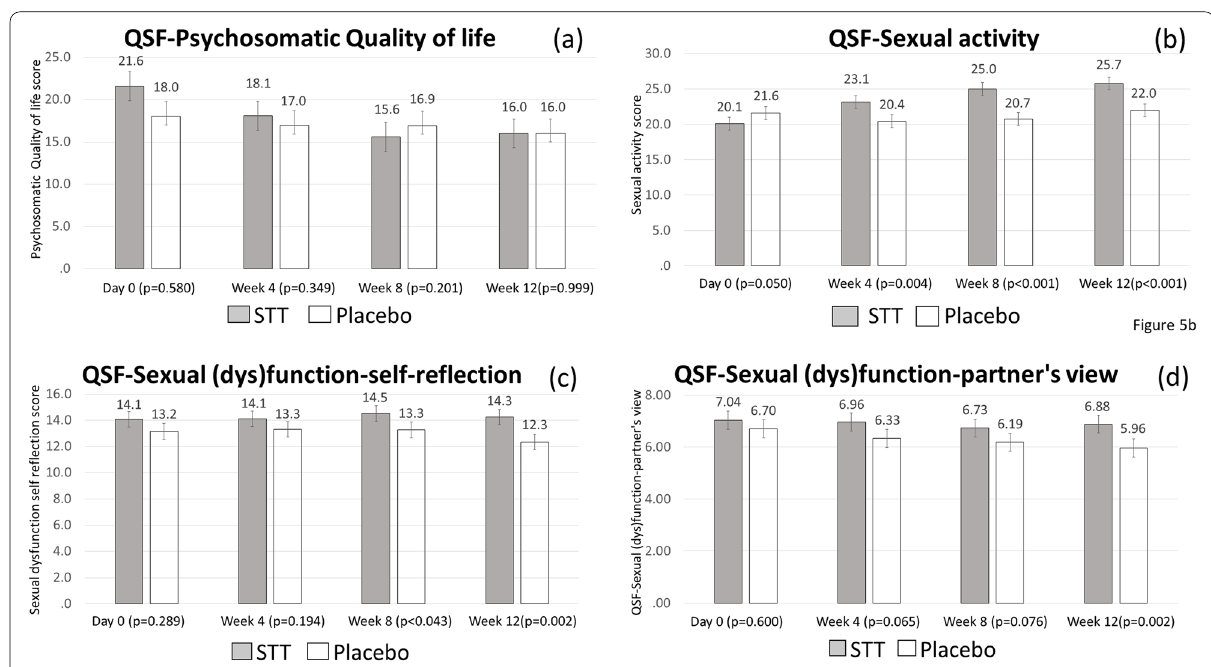
Fig. 5 Comparison of adjusted means improvement in each Quality of Sexual Function (QSF) component scores between the STT and placebo groups during the follow-up period of the study: a. QSF-psychosomatic quality of life; b. QSF-sexual activity; c. QSF-sexual (dys)function (-self-report), d. QSF-sexual (dys)function (partner’s view). Treatment with STT (the gray column, N scores of sexual function quality in men compared with those of the placebo group (the white column, N QSF-sexual (dys)function (self-report) ( p < 0.043), and QSF-sexual (dys)function (partner’s view) ( p There was no significant difference in QSF-psychosomatic quality of life between the STT and placebo